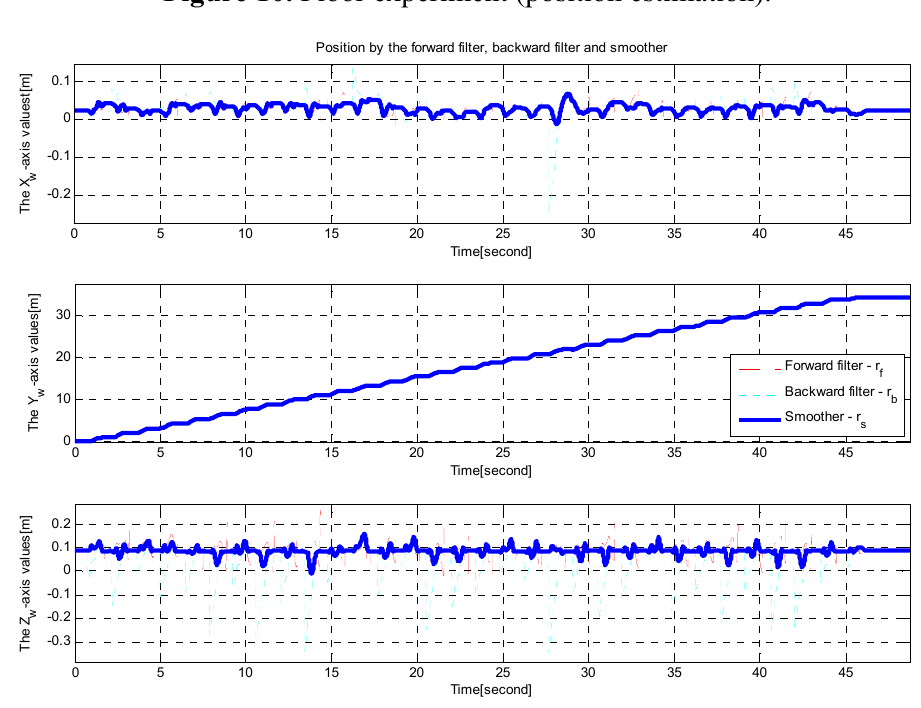
Figure 10. Floor experiment (position